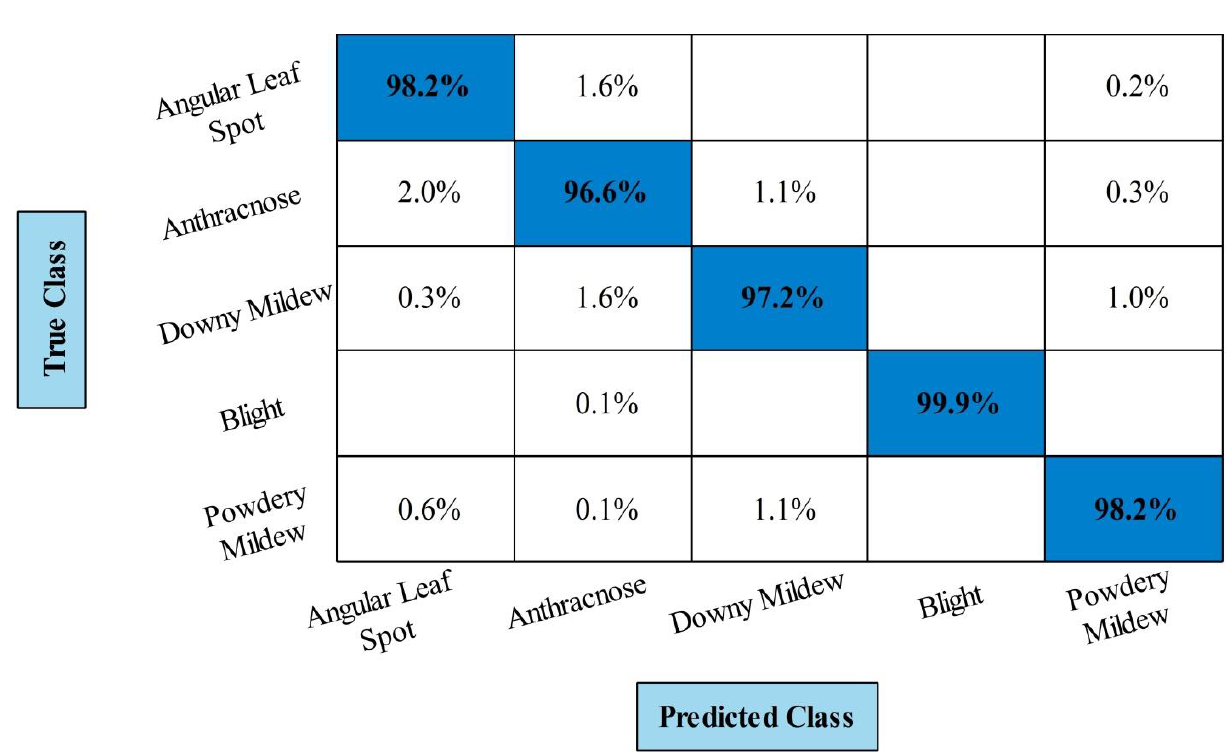
Figure 5. Confusion matrix of Cubic SVM after employing feature selection technique.